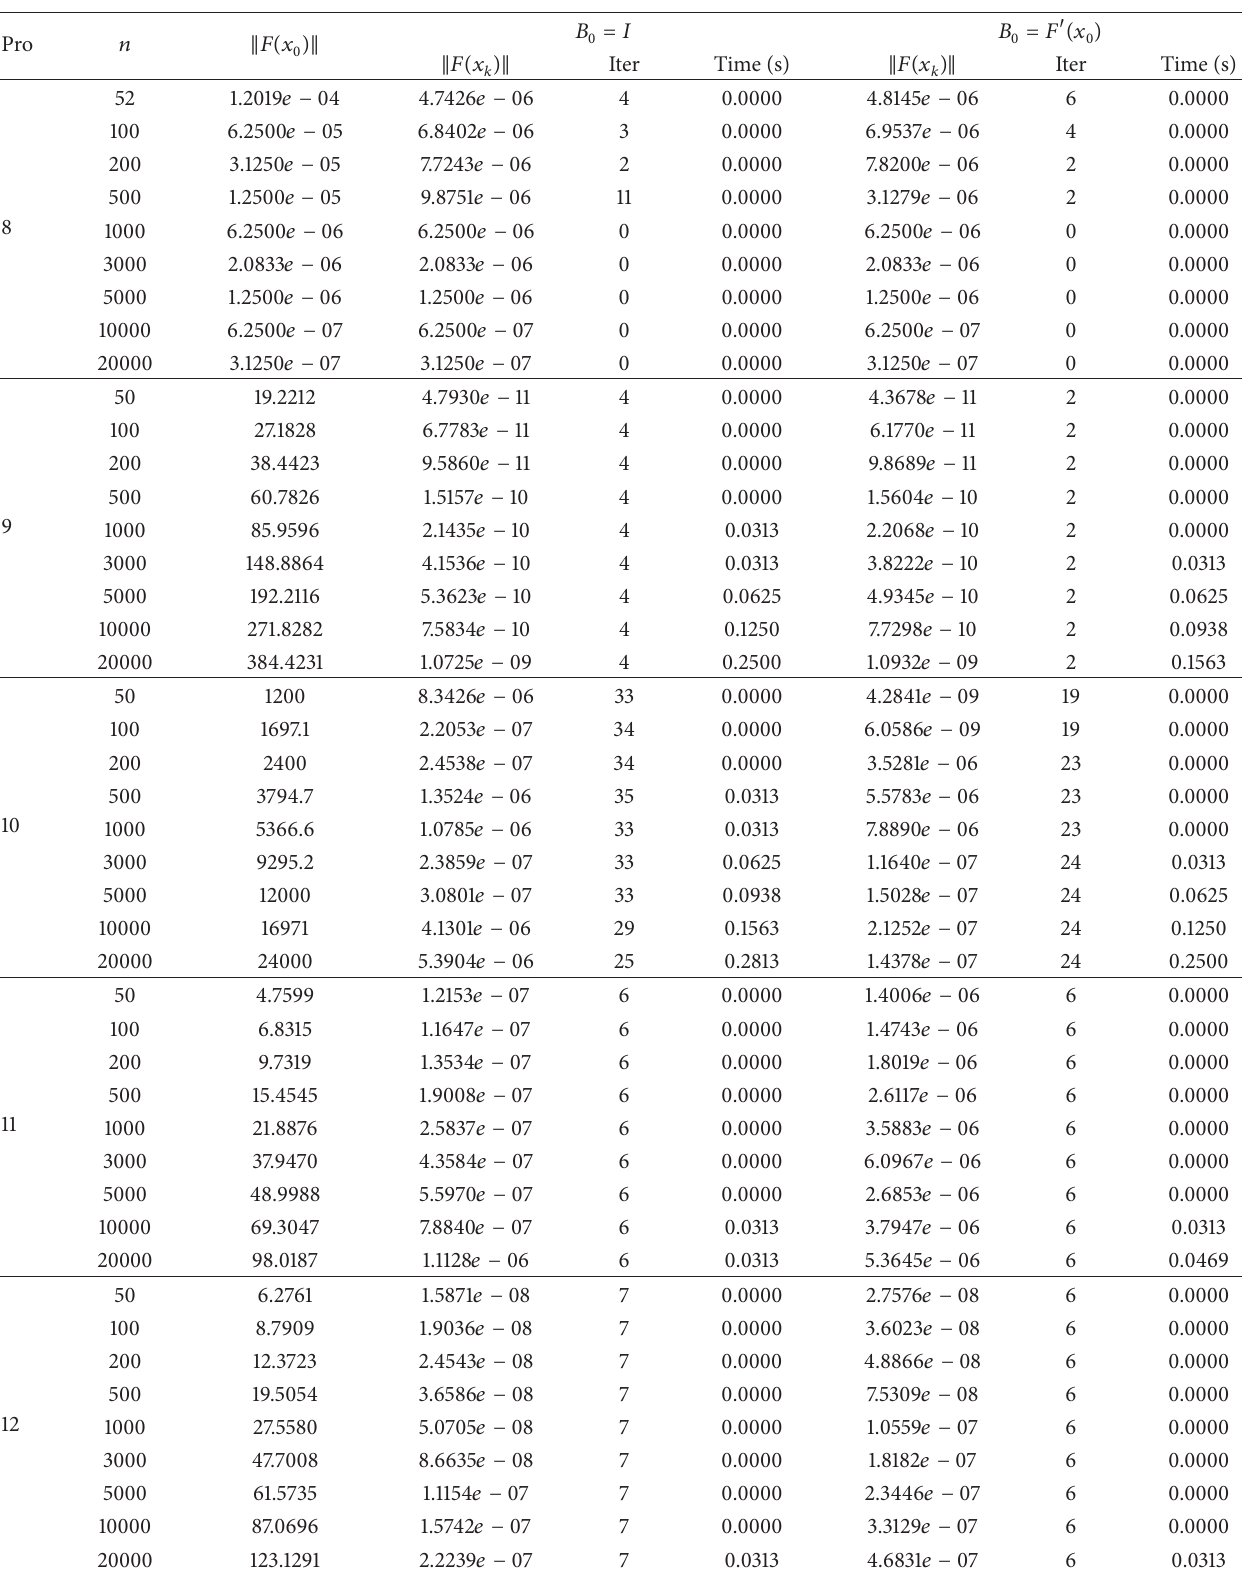
Table 2: Results of Algorithm 3 for Problems